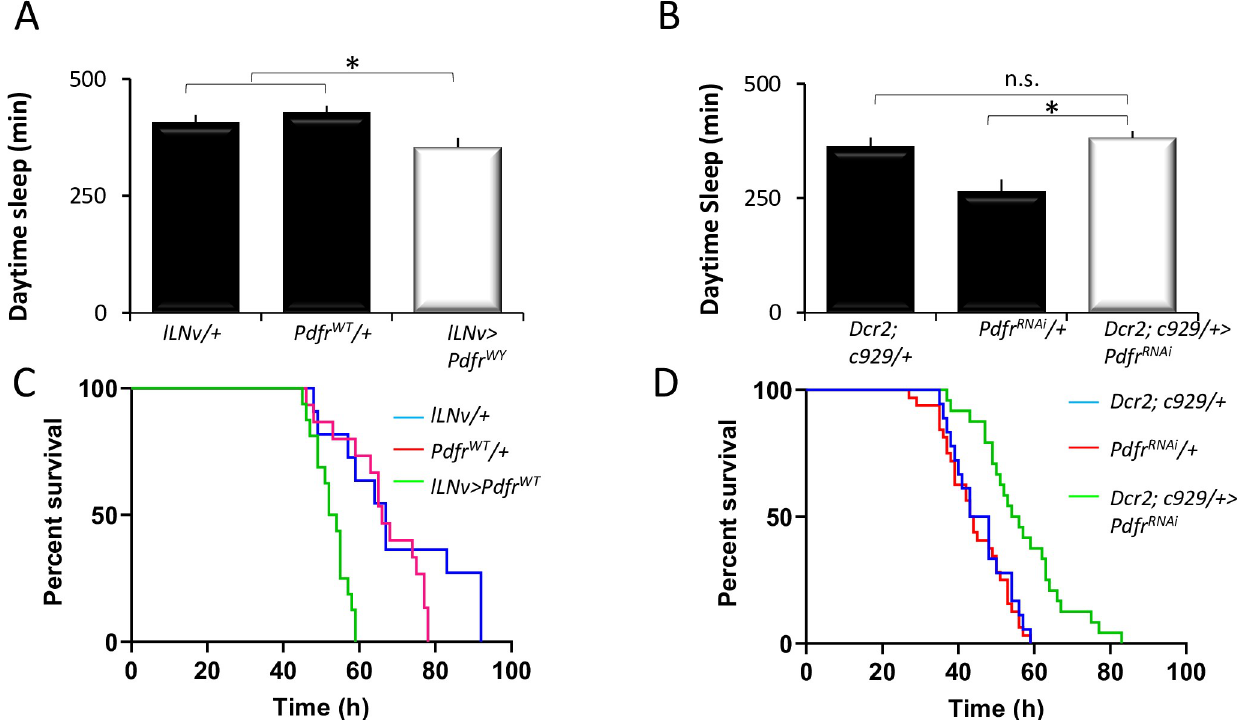
Fig 4. Behavioral consequences of PDFR expression in l-LNvs. (A) Daytime sleep in 5-day-old l-LNv-GAL4 > ; UAS-Pdfr WT /+ flies and parental controls (ANOVA [2,92] = 5.7 p = 0.004; n = 30–32/genotype). (B) Sleep in Dcr2; c929- GAL4/UAS- Pdfr flies and parental controls (ANOVA [2,150] = 17.24 p = 1.86 E-07 ; n = 40–60/genotype; � p < 0.05, modified Bonferroni test). (C) Kaplan–Meier analysis reveals % survival during starvation in l-LNv-GAL4 > ; UAS-Pdfr WT flies and parental controls ( n = 3 replicates of 10–16/genotype, χ 2 = 19.55, df = 2, p -value < 0.0001). (D) Kaplan–Meier analysis reveals % survival during starvation in Dcr2; c929-GAL4/UAS-Pdfr RNAi flies and parental controls ( n = 3 replicates of 10–16/genotype, χ 2 = 23.35, df = 2, p -value < 0.00001). Data underlying this figure can be found in S4 Data. l-LNv, large ventral lateral neuron; n AU : Pleasedefinen : s : inFig 4 abbreviationlistifthisindeedisanabbreviation : .s., not significant; PDFR, pigment dispersing factor receptor.